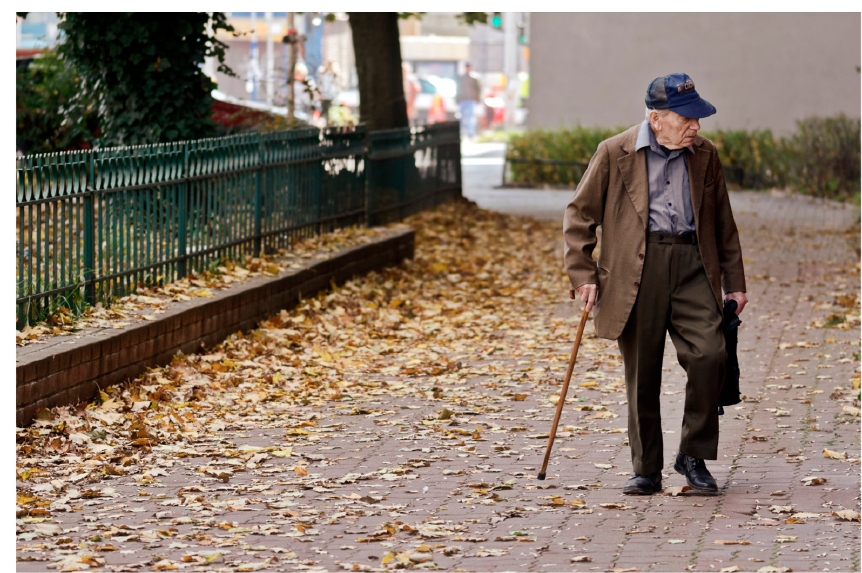
Figure 3. Older man with a cane. Source, Pixabay. https://www.canva.com/photos/MADyQ5rAJ-0-